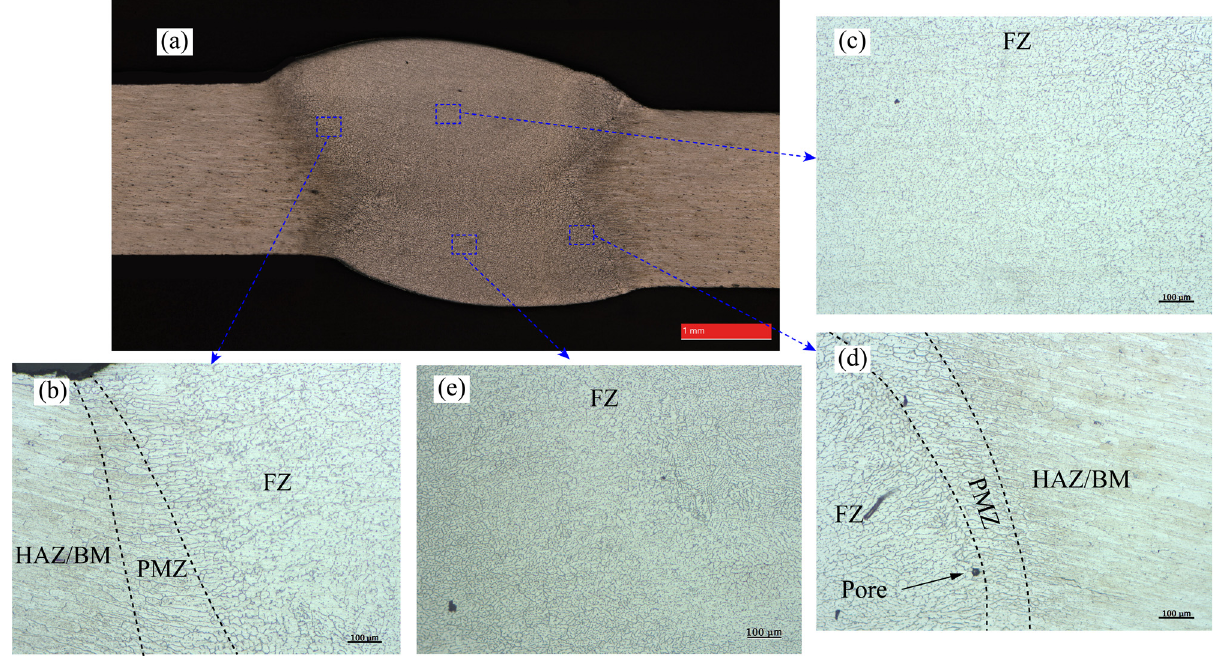
Figure 6: Case 1: metallographic